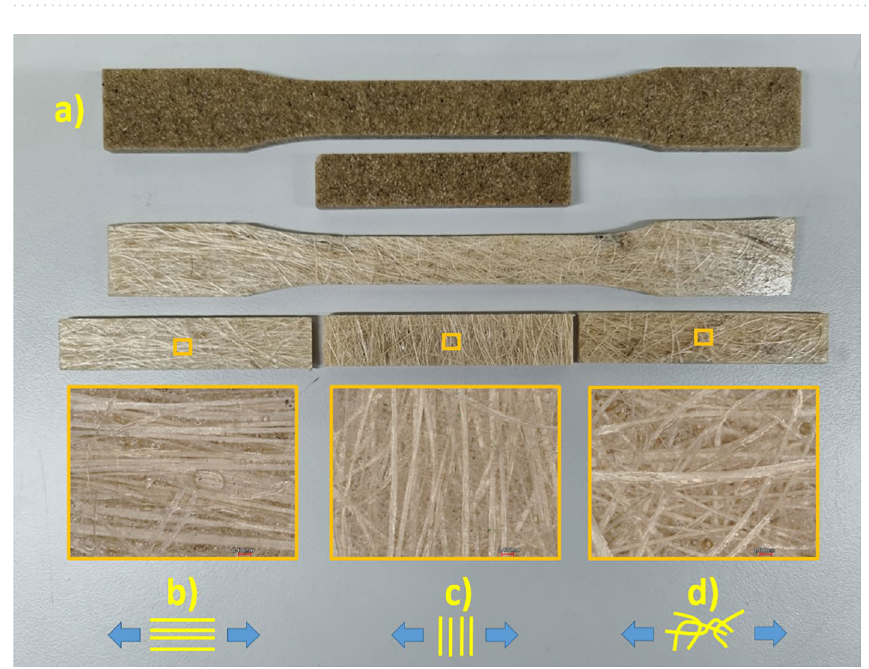
Figure 4. Tensile and flexural samples of ( a ) EP-FP ( b ) EP-UF 0° ( c ) EP-UF 90° and ( d ) EP-NWF